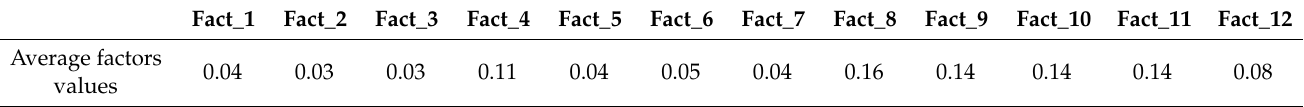
Table 9. Average factors values from the point of view of the surveyed